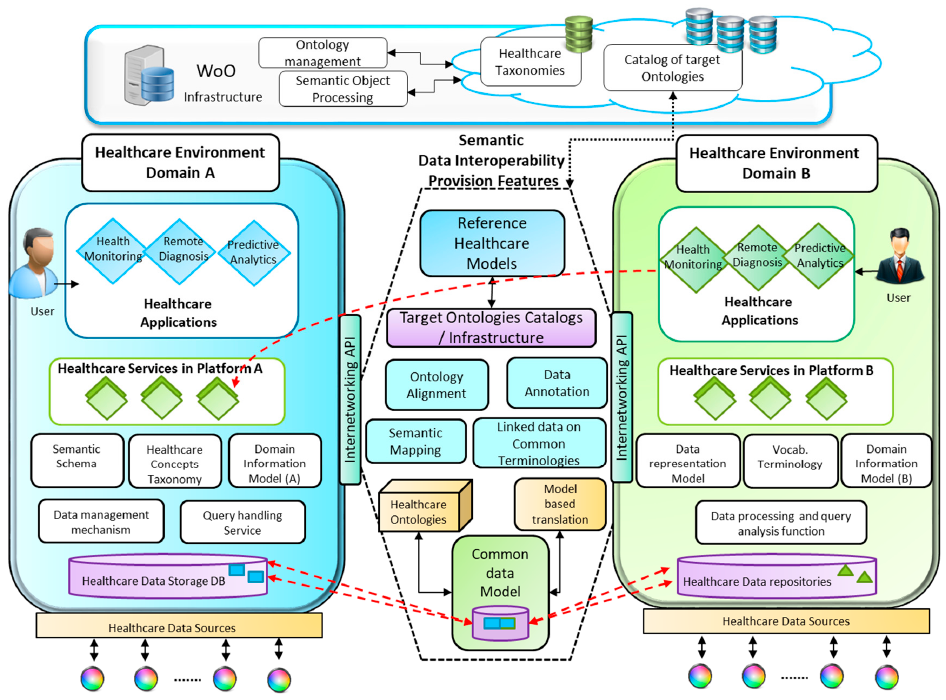
Figure 4. Semantic mediation model in heterogeneous healthcare service environments.